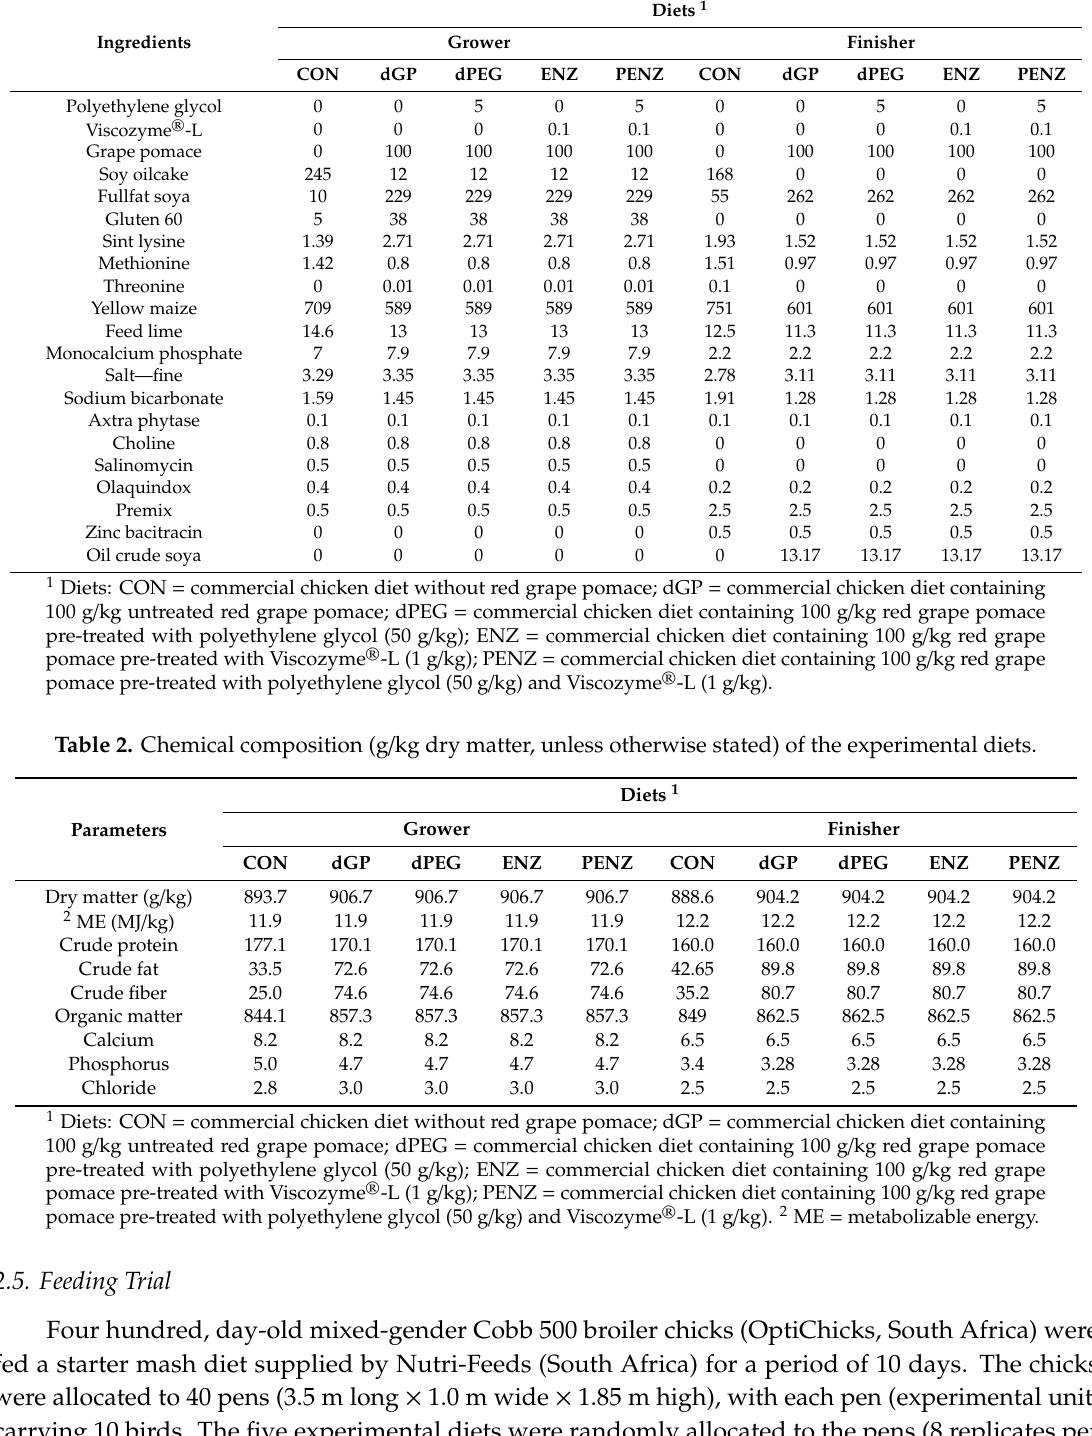
Table 1. Ingredient composition (g / kg dry matter, unless otherwise stated) of the experimental diets.